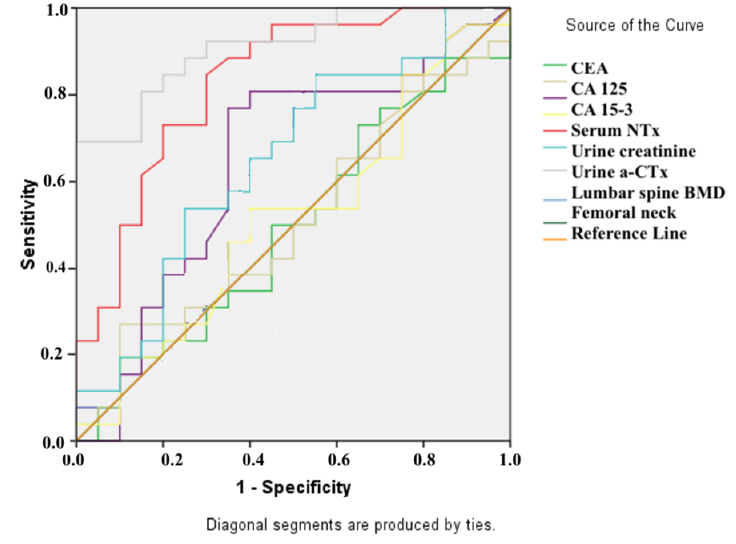
Figure 2 . ROC analysis results for distinguishing breast cancer patients with metastasis from breast cancer patients without metastasis.